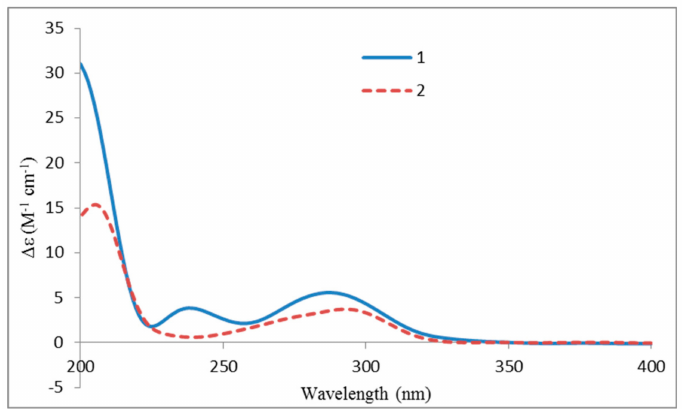
Figure 3. ECD spectra of 1 and 2